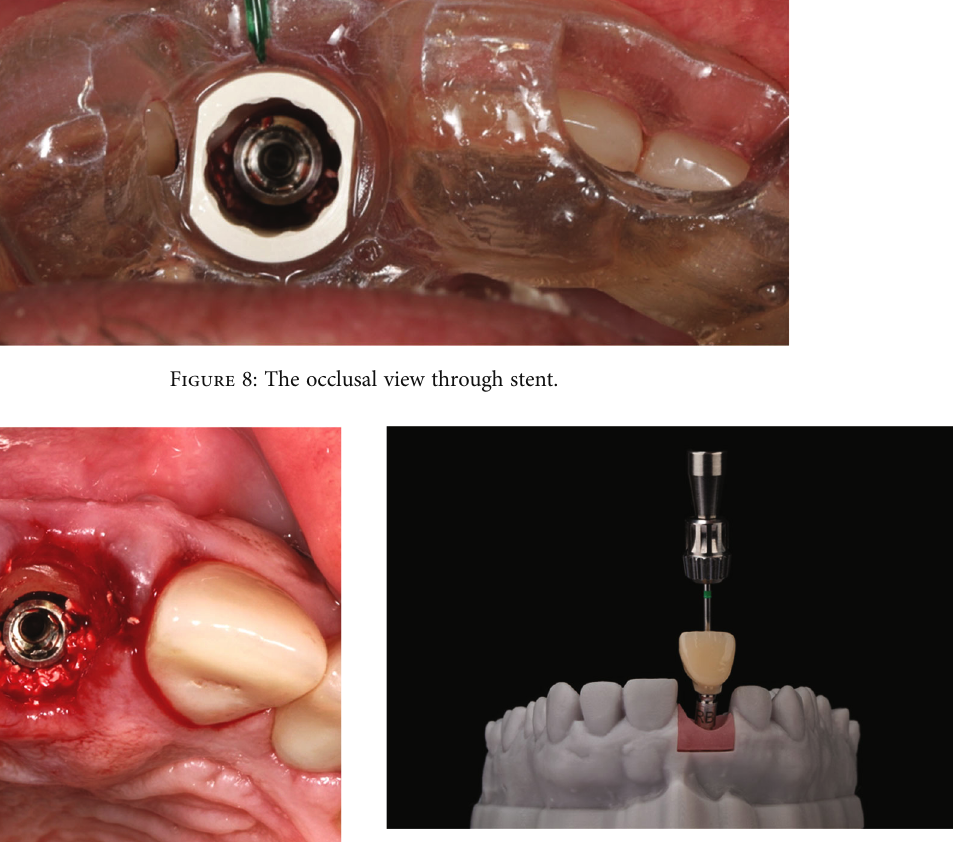
Figure 10: The temporary crown on the 3D printed lab